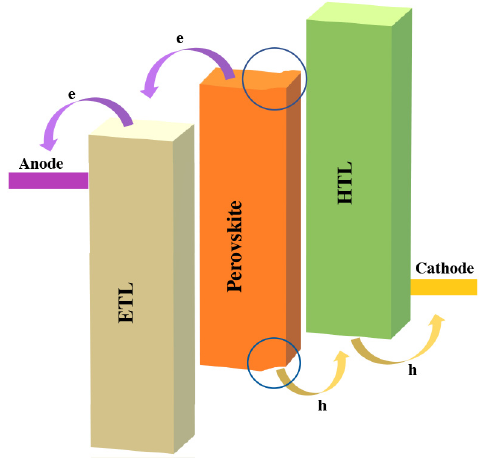
Fig. 15. Perovskite surface energy levels shifting scheme. The regions shown in the blue circles show the shifted conduction and valence bands of the perovskite layer near the perovskite/HTL interface. Both the conduction and valence bands are shifted by the same